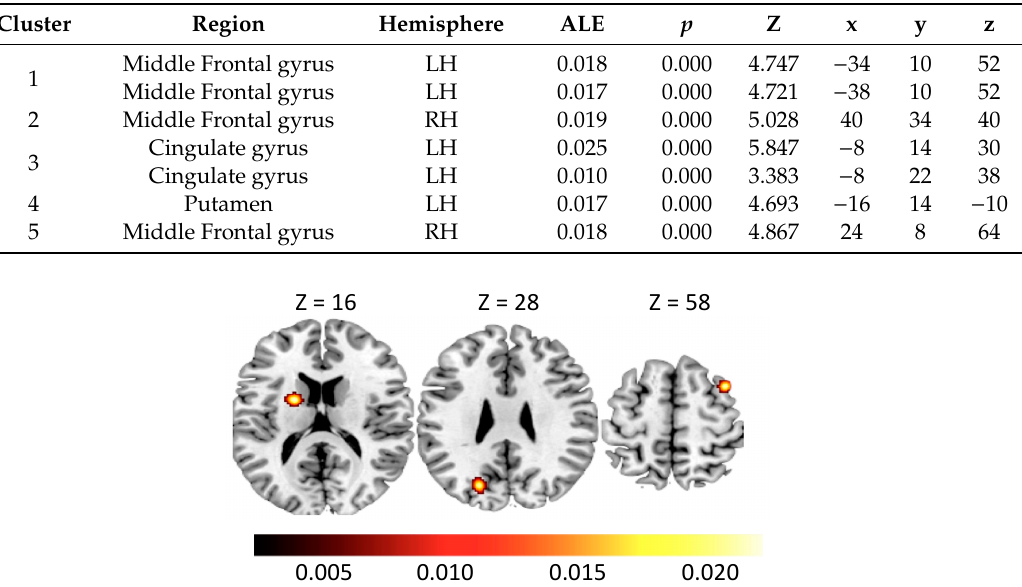
Figure 4. Clusters of deactivation in Alcohol Use Disorder subjects. MNI coordinates are provided. The color bar indicates ALE values.